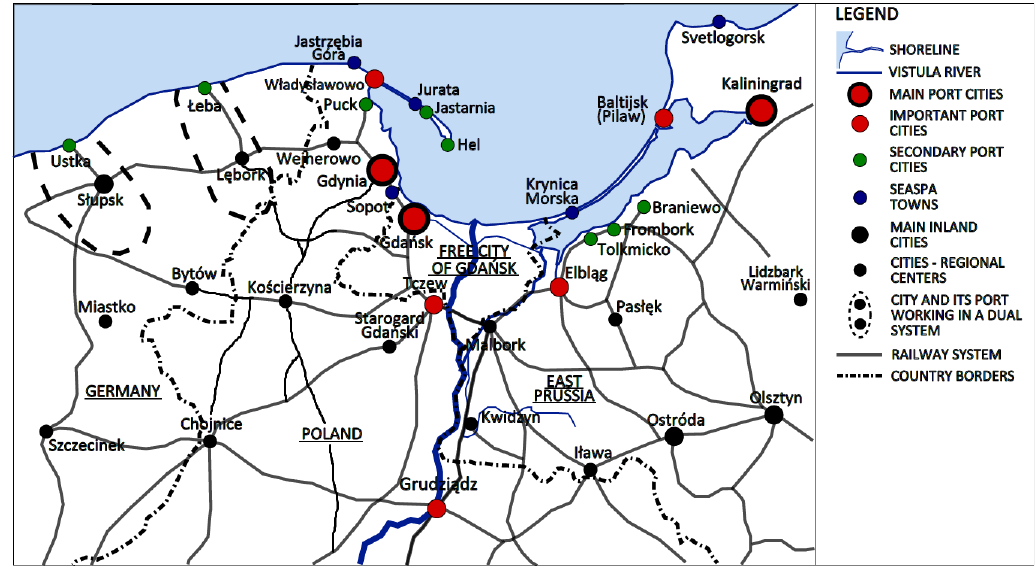
Figure 6. Gdańsk Bay port region geography during the interwar period. Source: Authors based on Lijewski and Koziarski